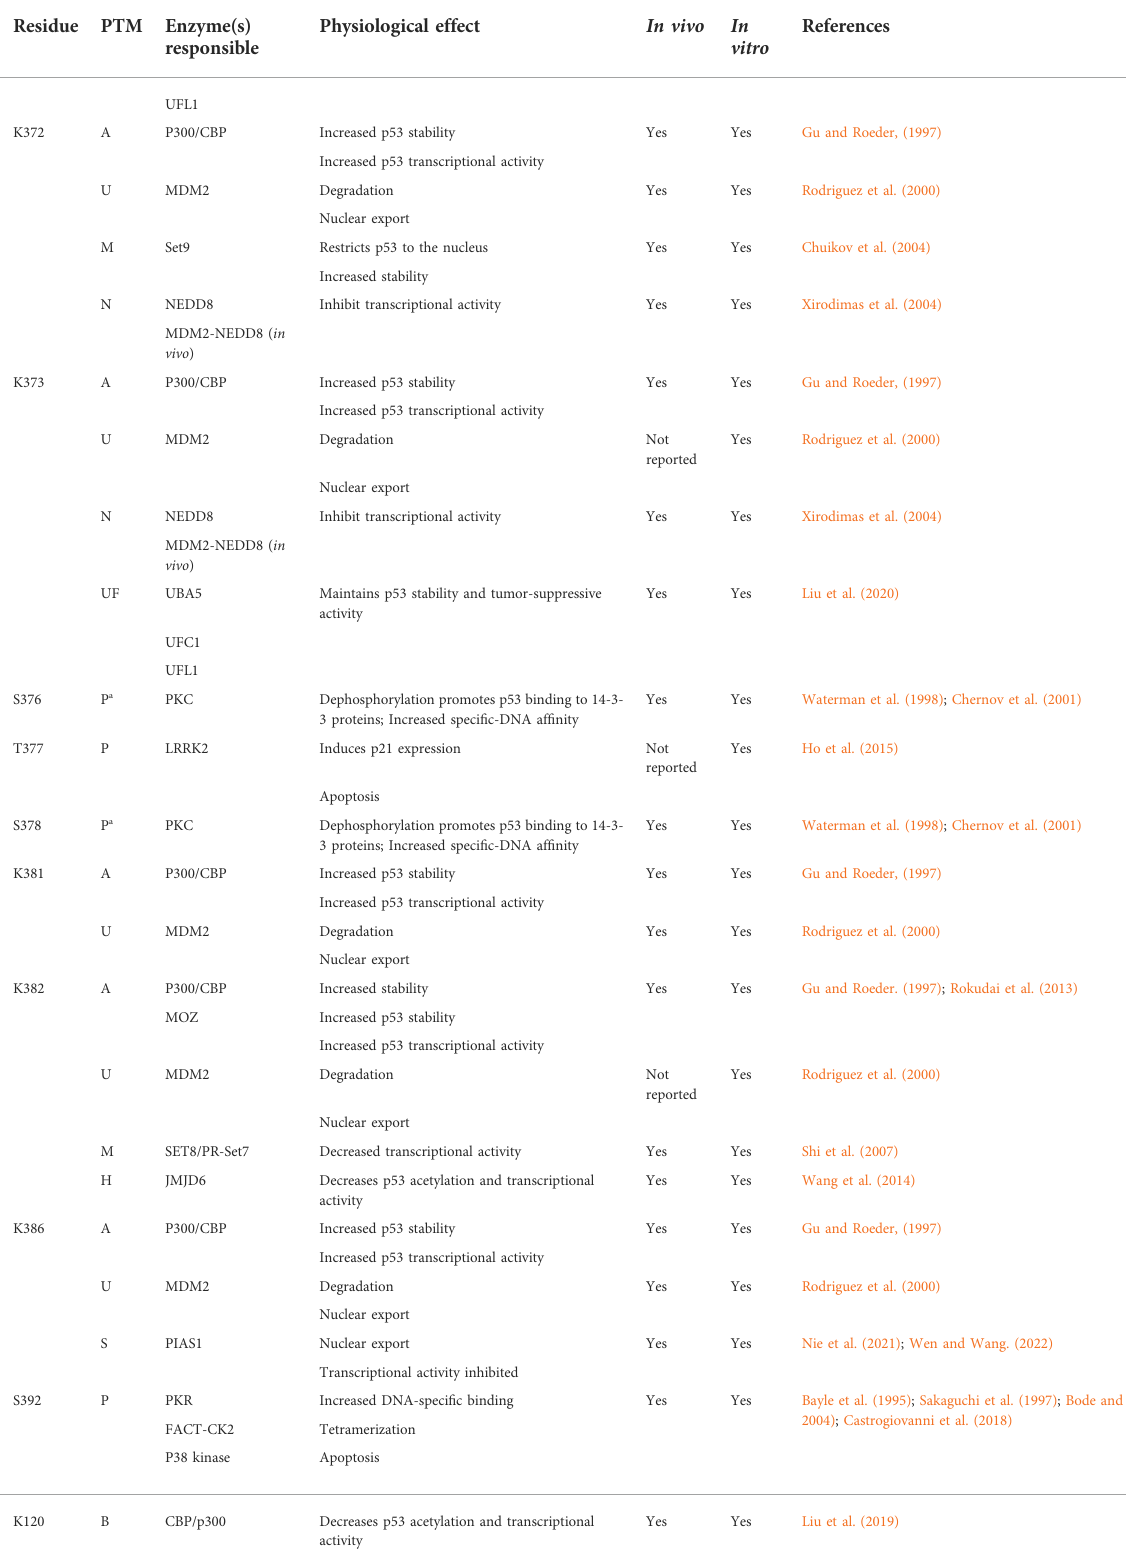
TABLE 1 ( Continued ) The molecular antennas: NTD and CTD p53 residues with